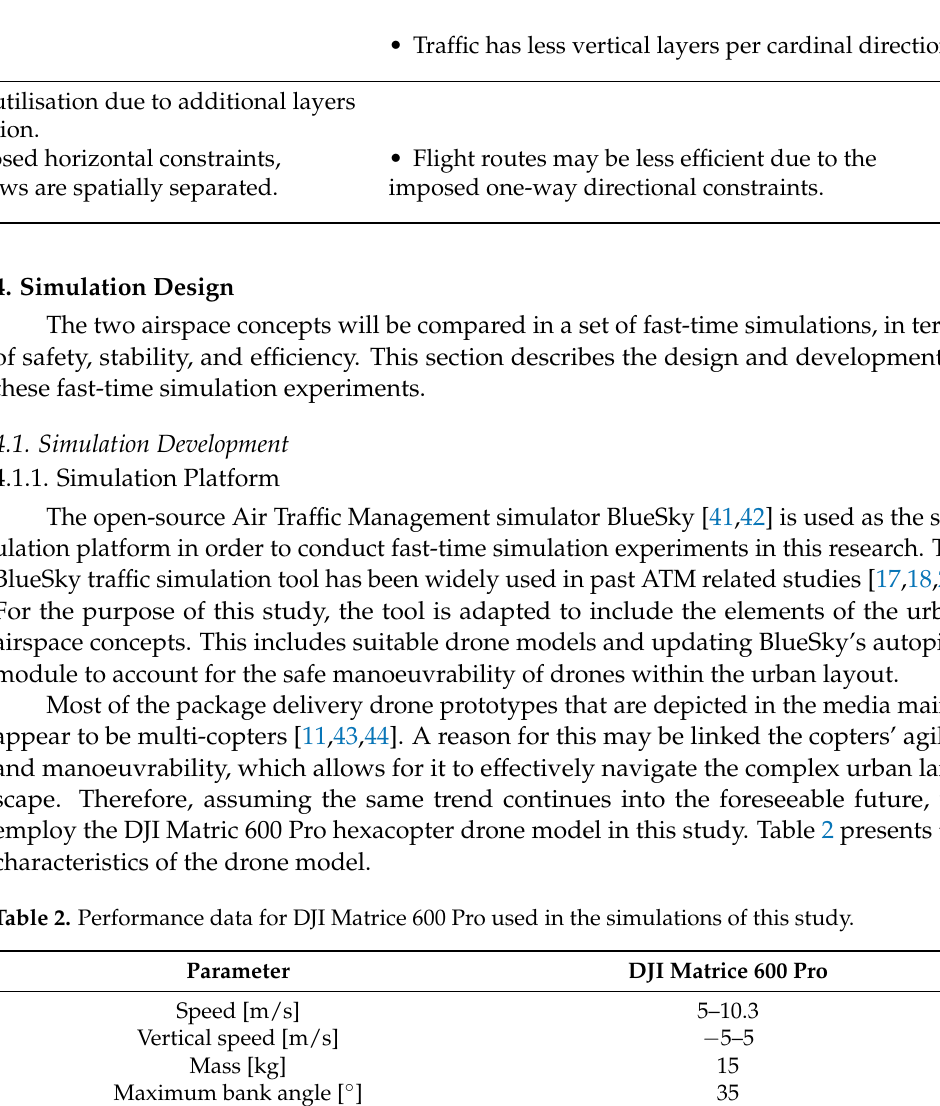
Table 1. The main pros and cons of the two-way and one-way urban airspace concepts. Concept Advantages Disadvantages Two-way